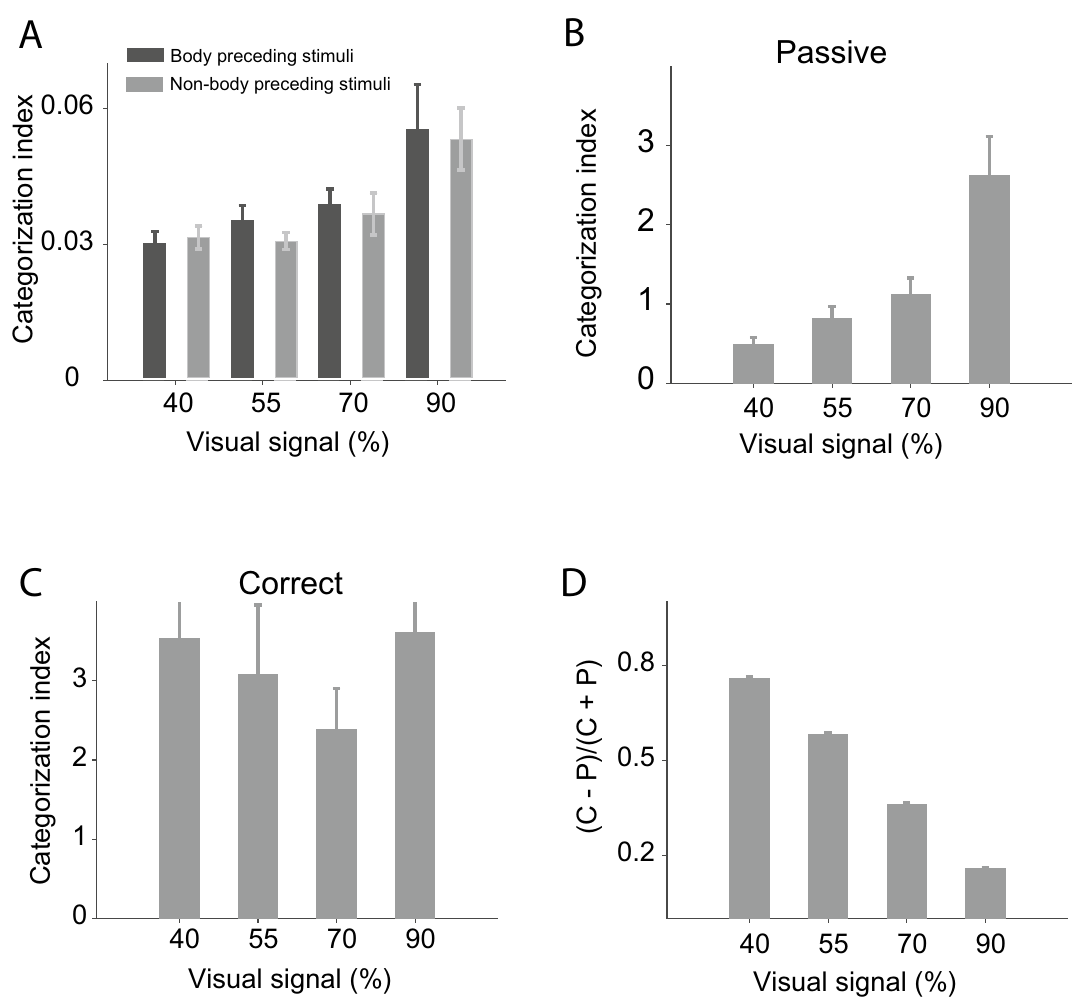
Figure 6. The potential impact of spike contamination evoked by preceding stimuli. The trials were divided into two groups for each neuron: trials in which body images preceded the stimulus and those in which a non- body image precedes the stimulus. ( A ) The mean values of CI in the passive condition from 150 to 350 ms after stimulus onset were plotted for each group, separately. Bar graphs illustrate the CI during 150 to 350 ms after stimulus onset in rate-matched populations in passive ( B ) and correct ( C ) trials. ( D ) Category information in the correct, compared to passive, trials during rate-matched population. Error bars represent the STD of bootstrap